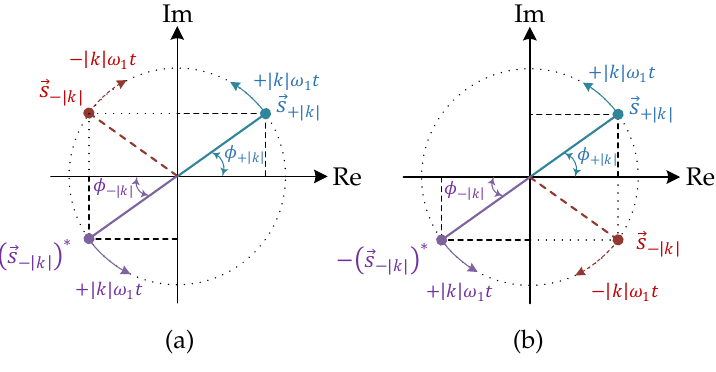
Figure 2. Independent representation of power vectors—( a ) Transformation for real power cancellation; ( b ) Transformation for imaginary power